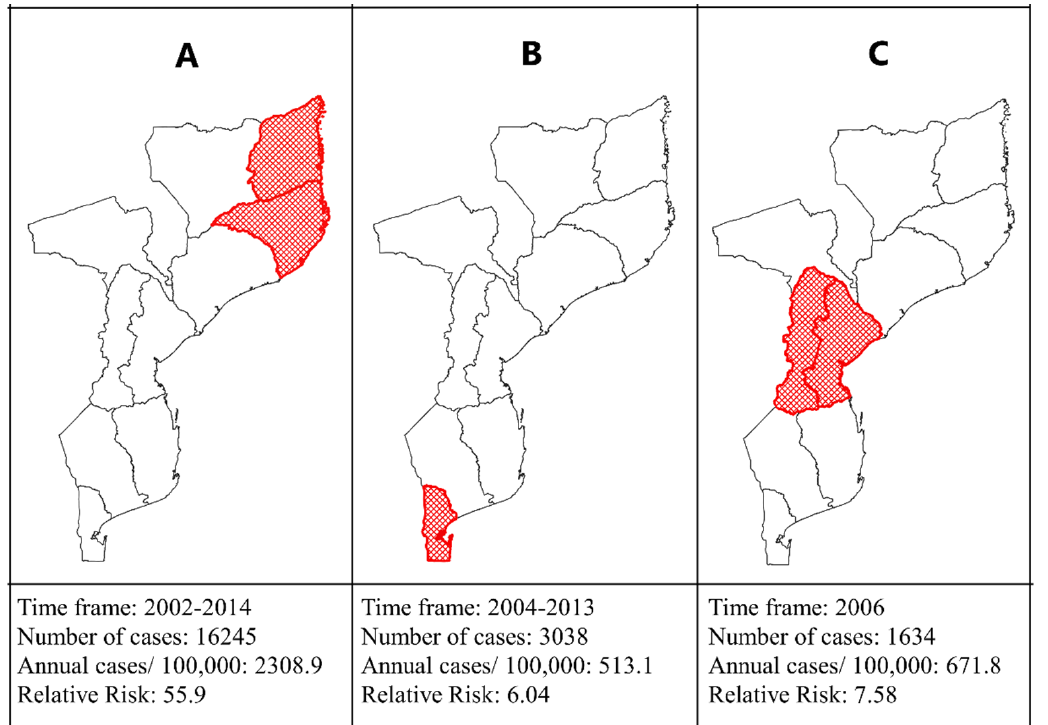
Figure 5. Spatiotemporal distribution of African swine fever in Mozambique between 2000 and 2020. Red represents clusters formed: primary ( A ) and secondary clusters ( B , C ).